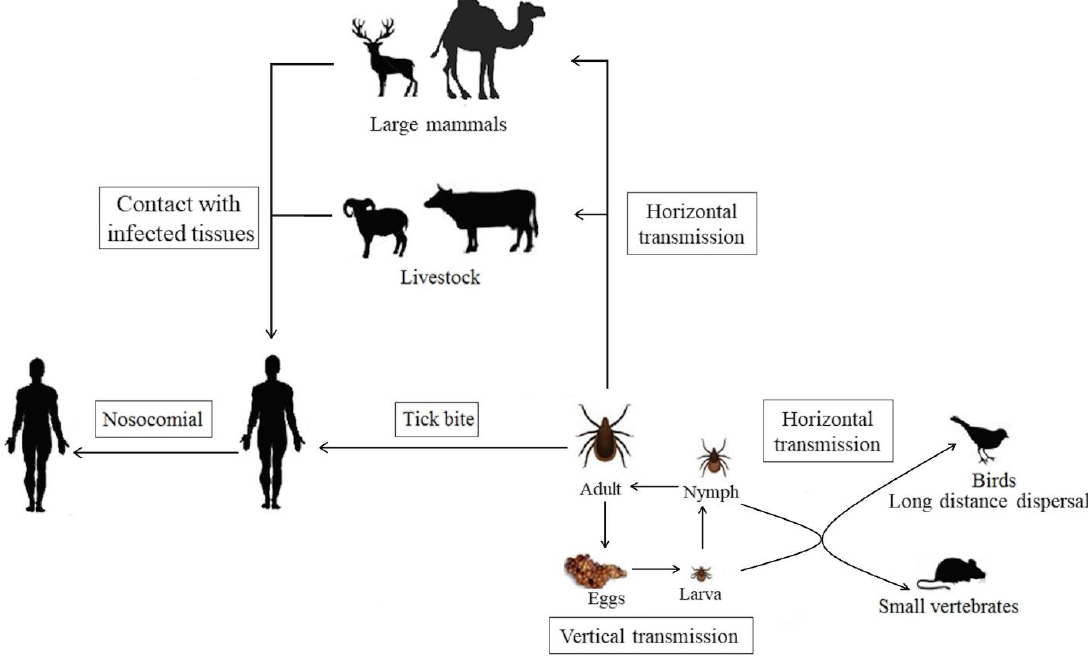
Figure 2. The transmission cycle of CCHFV. The boxes show transmission